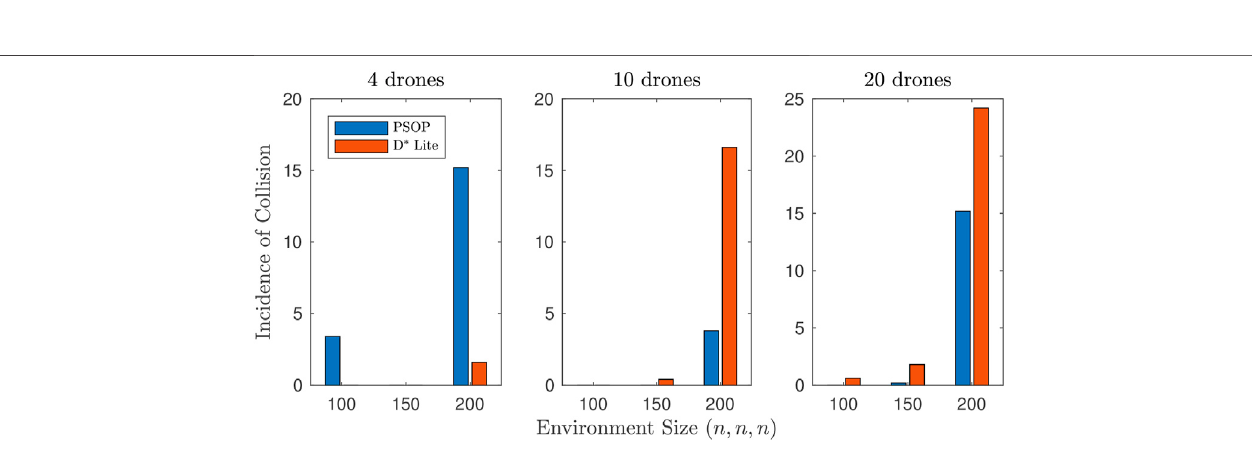
FIGURE 7 | Mean incidence of collision by environment size (drone-to-environment). For a system of 4 drones, p-drones recorded a greater number of collisions between drones and the environment (6.2 collisions per scenario, average across all environment sizes) than d-drones (0.5 collisions per scenario, average across all environment sizes). Whereas for systems of either 10 or 20 drones p-drones recorded fewer collisions between drones and the environment (1.3 and 5.1 collisions per scenario respectively, average across all environment sizes) when compared to d-drones (5.7 and 8.9 collisions per scenario respectively, average across all environment